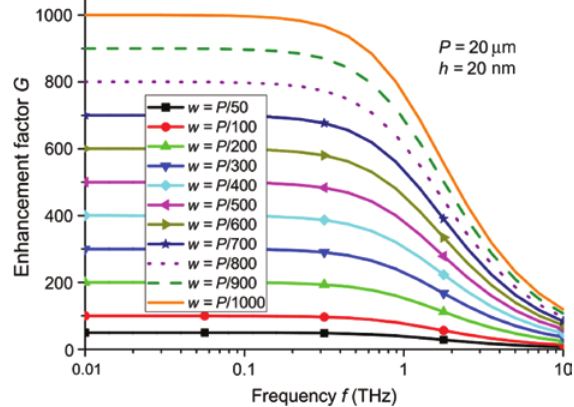
Figure 9: Field enhancement in periodic arrays of slit, clearly exhibiting that the enhancement factor is strongly limited by the subwavelength period P . This figure is reproduced from Ref. [89].